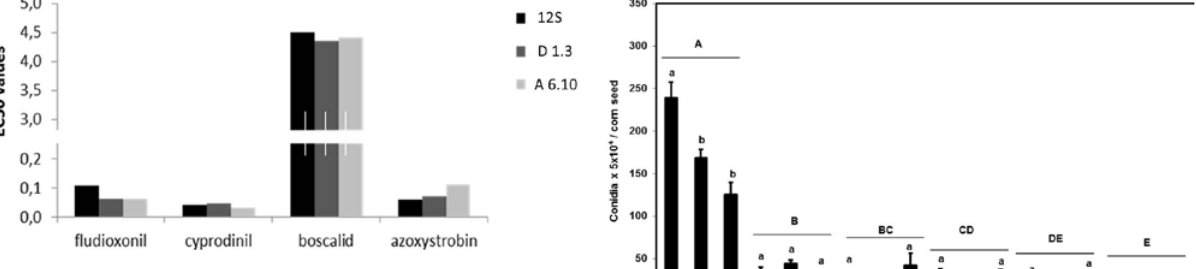
Figure 1. EC 50 values for fludioxonil, cyprodinil or boscalid for inhibition of mycelium growth, and for azoyzstrobin for inhibition of conidium germination, of Aspergillus flavus strains 12S, D1.3 and A6.10. Figure 2. Mean numbers of conidia produced by Aspergil- lus flavus strains D1.3, A6.10 and 12S in maize seeds treated with different fungicides. Within treatments, columns ac - companied by different lower case letters are significantly different ( P ≤0.05) among strains, and upper case letters in - dicate differences ( P ≤0.05) between the fungicides. Vertical bars indicate standard errors of the means.